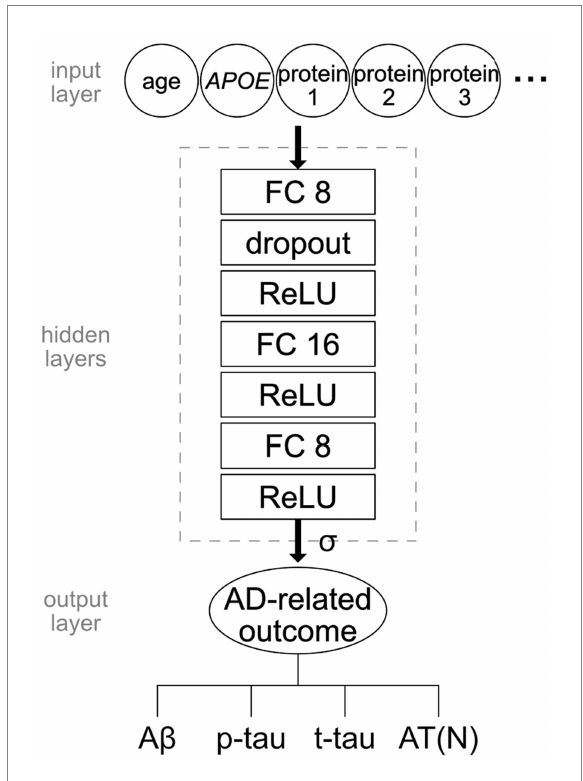
FIGURE 1 Structure of the NN model. The dimension of the input layer was determined by the number of features including age, APOE status, and/or protein levels. The hidden layers consisted of three fully connected layers of size 8, 16, and 8 connected by ReLU activation function. Dropout of rate 0.5 was applied to the output of the first hidden layer. The final output was transformed by a sigmoid function. Four AD-related measures were independently tested as outcomes: A β , p-tau, t-tau, and